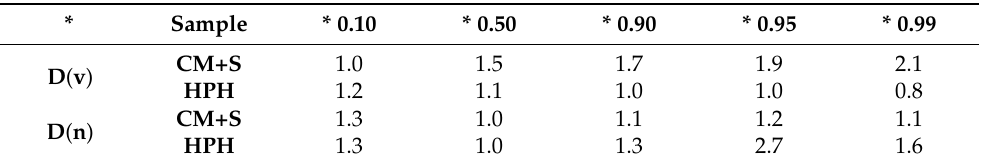
Table 1. The size ratio of samples without surfactant and with TPGS (D-value without surfactant divided by D-value stabilized with TPGS).